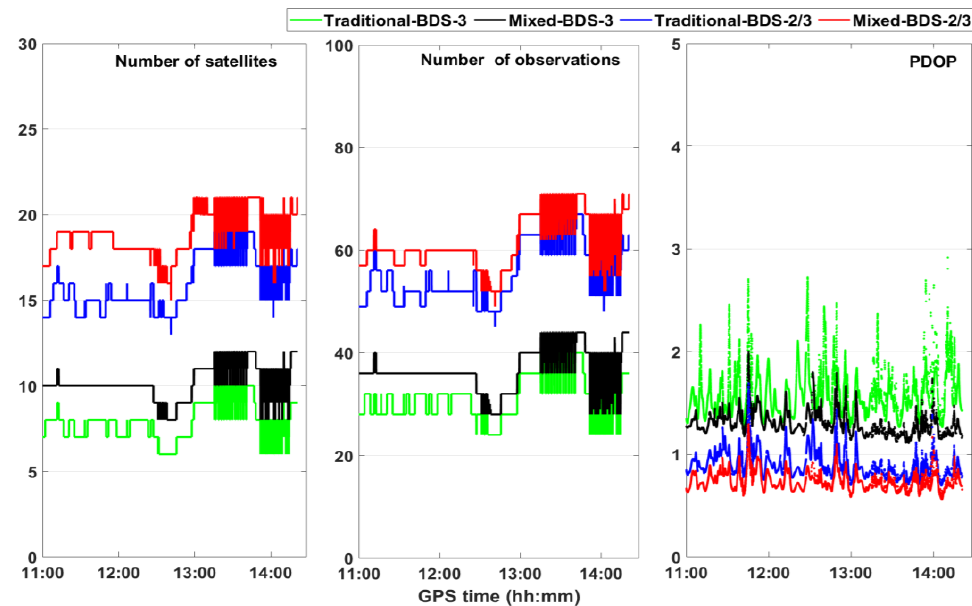
Figure 9. Number of satellites, number of carrier-phase observations and PDOP of kinematic PPP.